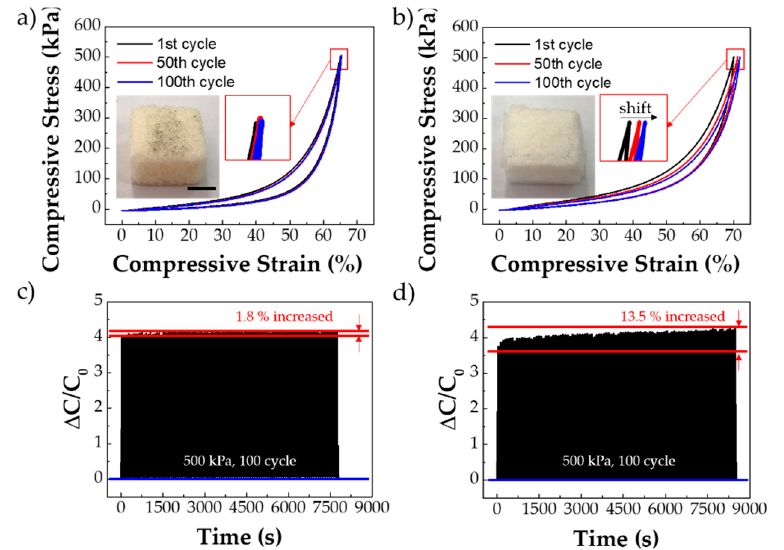
Figure 3. Comparison between the shape memory polymer (SMP) and CF95 porous structures. ( a ) Stress–strain curve of the SMP porous structure for 100 cycles of 500 kPa load; scale bar = 10 mm. ( b ) Stress–strain curve of the CF95 porous structure for 100 cycles of 500 kPa load. ( c ) Relative capacitance of the SMP porous structure for 100 cycle. ( d ) Relative capacitance of the CF95 porous structure for 100 cycles.